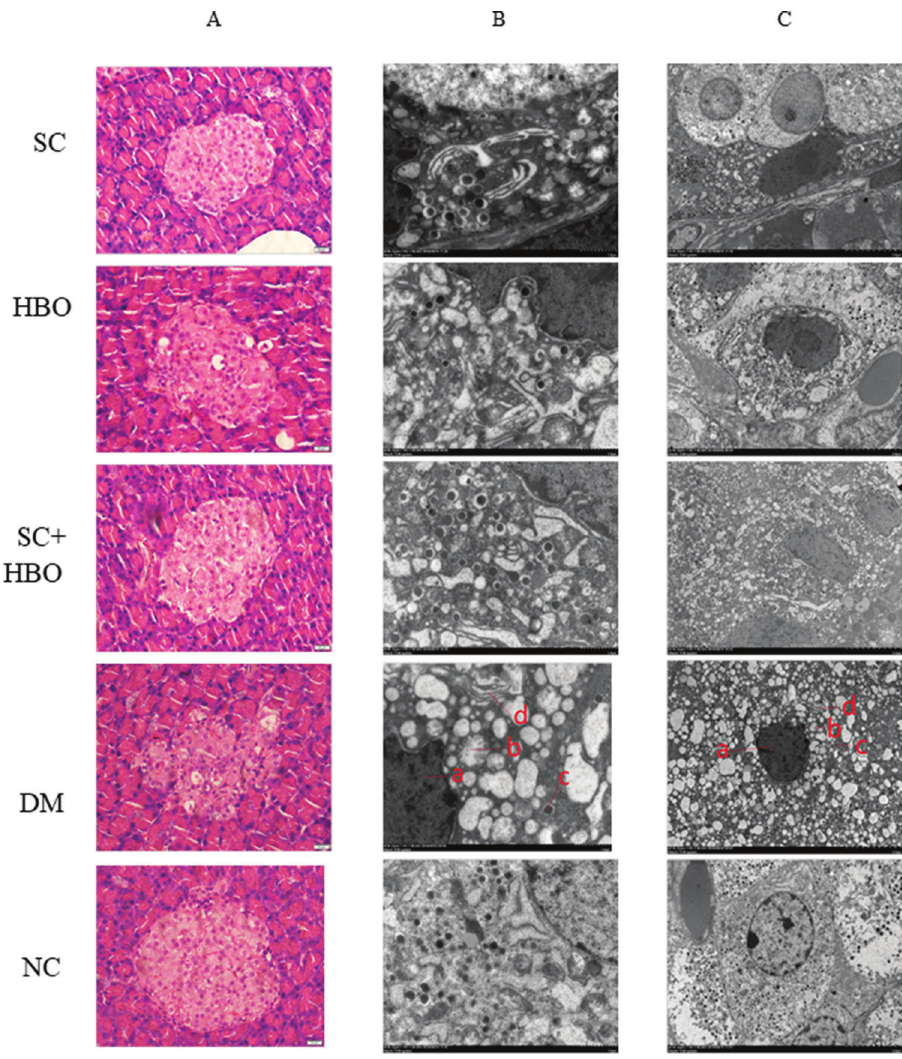
Figure 3 - Pathologic morphology of rat pancreas after 6 weeks of therapy. A. H&E staining: In the DM group, islet cells decreased and swollen cells and cytoplasmic vacuolar changes were observed; hyaline deposits were noted under the basement membrane of some islet capillaries, and inflammatory cells were scattered in the islets. The islet morphology in SC + HBO and SC groups was better than that in DM group. Scale bar: 20 m m, 400 (cid:1) . B. C. Electron microscopy of islet b -cells: In comparison with the b -cells in DM group, those from SC + HBO and SC groups showed decreased nuclear deformation, less swollen mitochondria, reduced lipid droplet accumulation, and significantly increased secretory granules. a. Nucleus; b. Mitochondria; c. Secretory granule; d. Ribosome. Scale bar: B.1 m m, 8000 (cid:1) ; C. 5 m m, 2500 (cid:1)